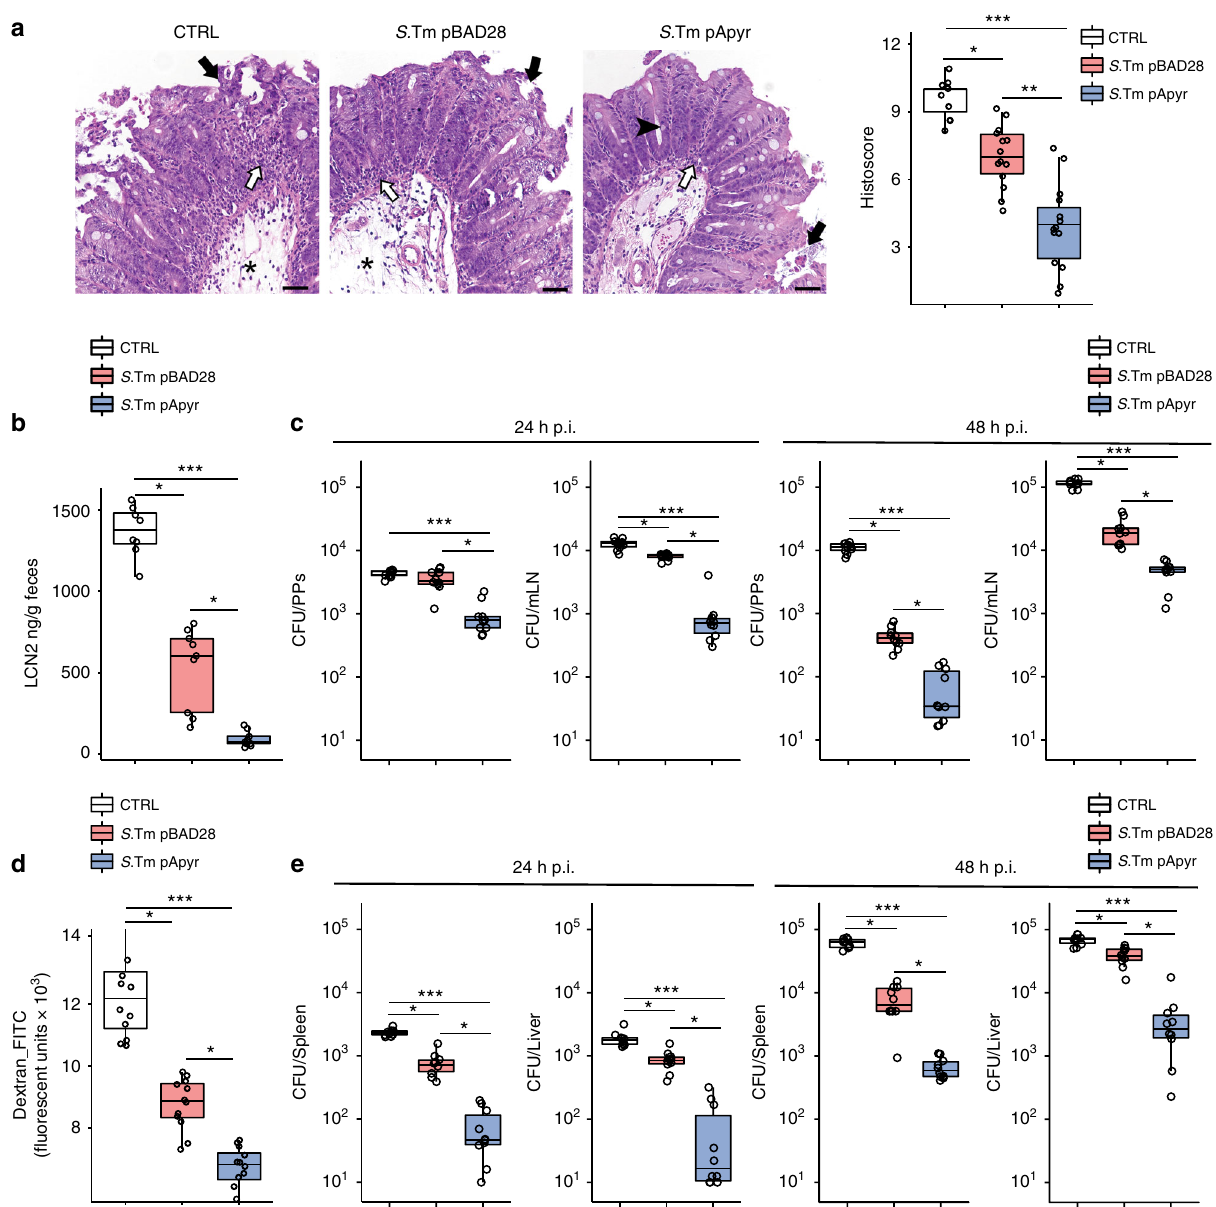
Fig. 5 Enhanced protection from Salmonella infection by vaccination with S .Tm pApyr . Wild-type mice were gavaged with PBS (CTRL) or vaccinated with S . Tm pBAD28 and S .Tm pApyr . Streptomycin (Sm) pretreated mice were infected with S .Tm WT and analysed 24 h and 48 h later. a Representative H&E sections of the cecum at 24 h post infection and statistical analysis of histopathological scores. Star: submucosal edema; white arrow: neutrophils aggregates; black arrow: epithelial defects; arrowhead: goblet cells. Scale bar: 50 μ m. b Fecal Lipocalin 2 (LCN2) quanti fi cation 24 h post infection with S .Tm WT . c Pathogen loads (CFU) in PPs and mesenteric lymph nodes (mLN) 24 h (left panels) and 48 h (right panels) after infection. d Intestinal permeability to FITC-dextran 24 h after infection with S .Tm WT in mice gavaged with PBS or vaccinated with S .Tm pBAD28 or S .Tm pApyr . Serum levels of 70-kDa FITC-dextran were assessed 4 h after gavage. e Pathogen loads (CFU) in spleen and liver 24 h (left panels) and 48 h (right panels) after infection. The boxplots show median and upper and lower quartiles. The extreme lines show the highest and lowest value . The boxplot is overlaid with the visualization of single observations. Kruskal – Wallis with Dunn ’ s post-test. * p < 0.05, ** p < 0.01, *** p < 0.001. One representative experiment out of three is